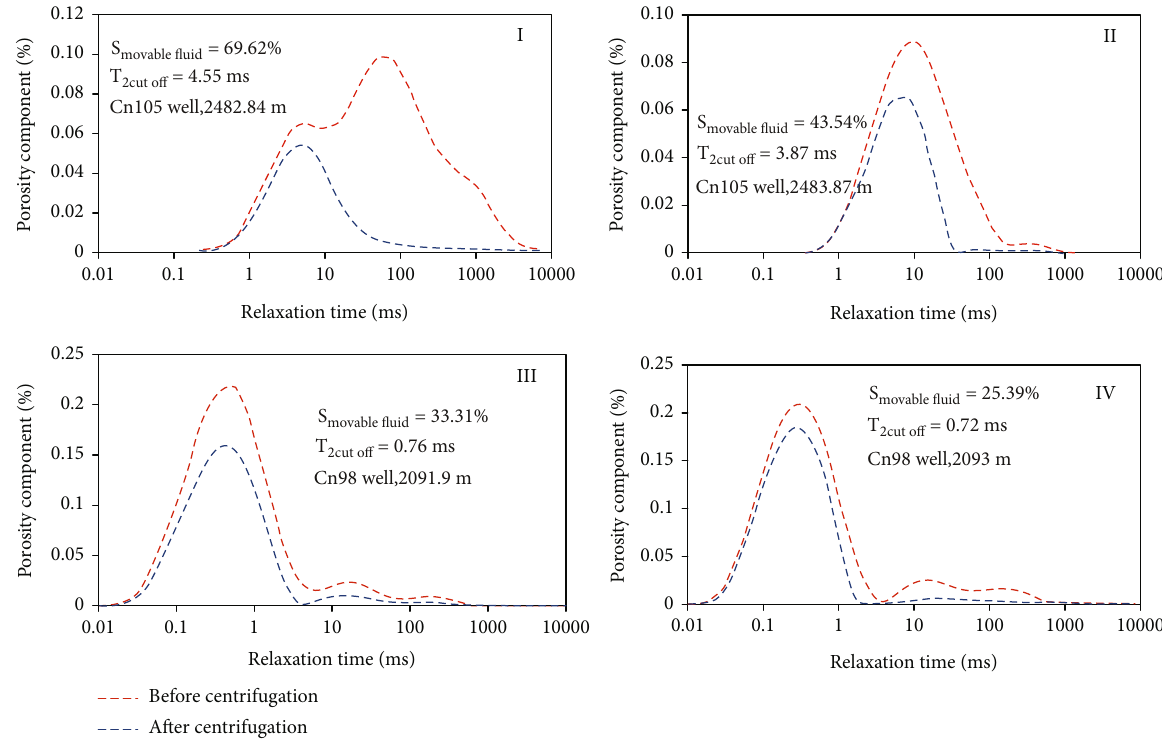
Figure 7: T 2 spectrum distribution of Shan 1 reservoir in Yanchang area. Table 3: Movable fl uid saturation of di ff erent sandstone